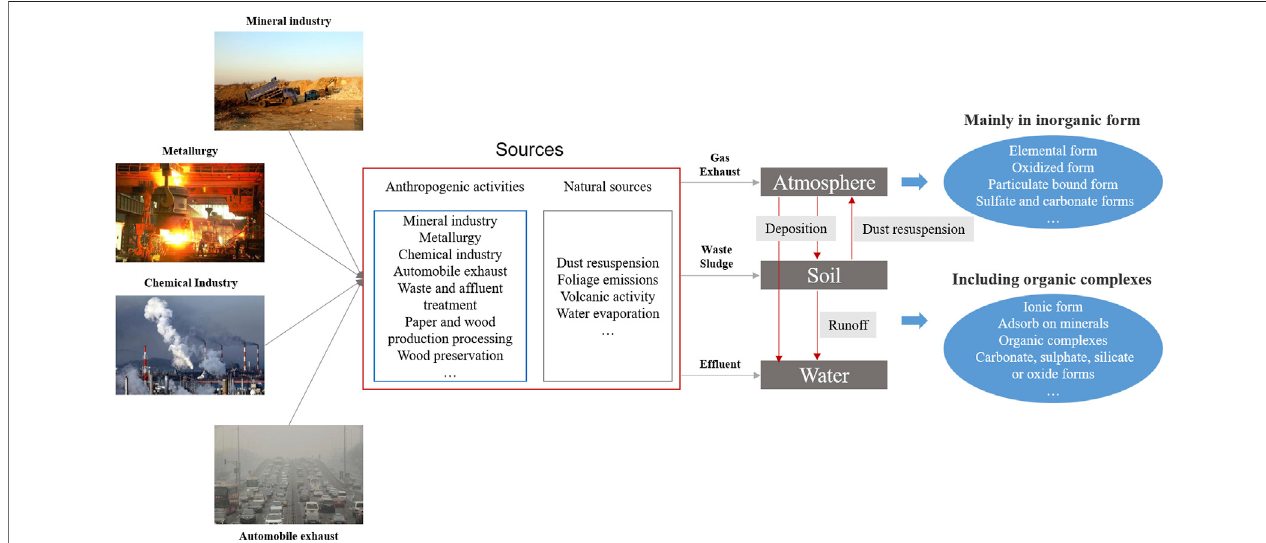
FIGURE 1 | The sources, migration, and speciation of HMs in different environmental media.